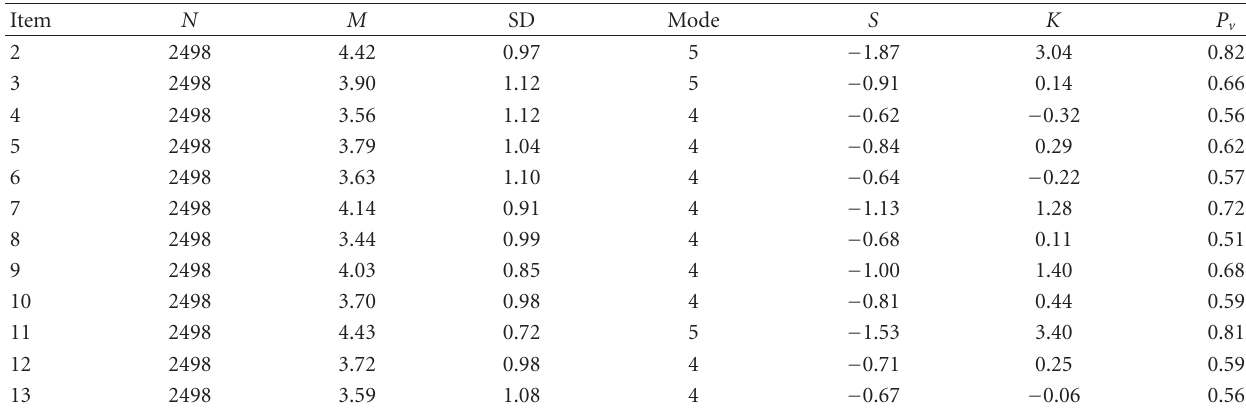
Table 7: Statistical parameters of the second validation.